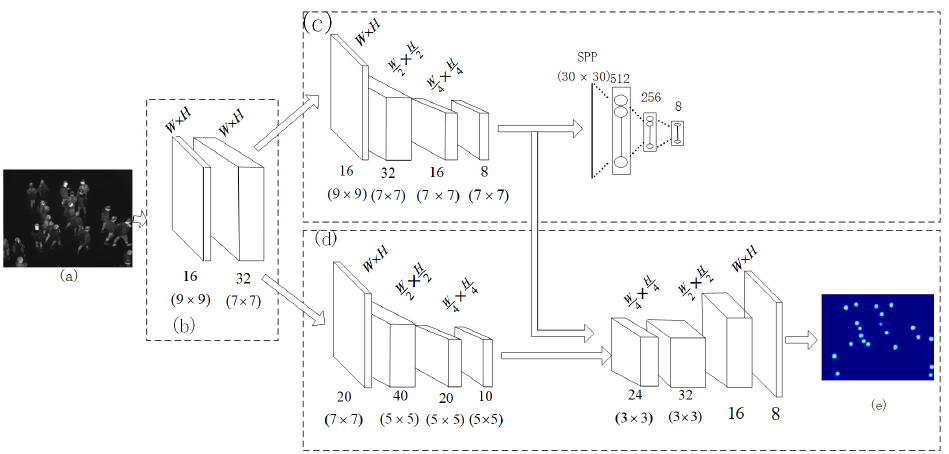
Figure 3. Schematic diagram of the MC-CNN. ( a ) Input infrared image; ( b ) shared CNN; ( c ) first stage; crowd-count classification; ( d ) second stage; crowd-density estimate; ( e ) crowd-density estimate map corresponds to the input infrared image.